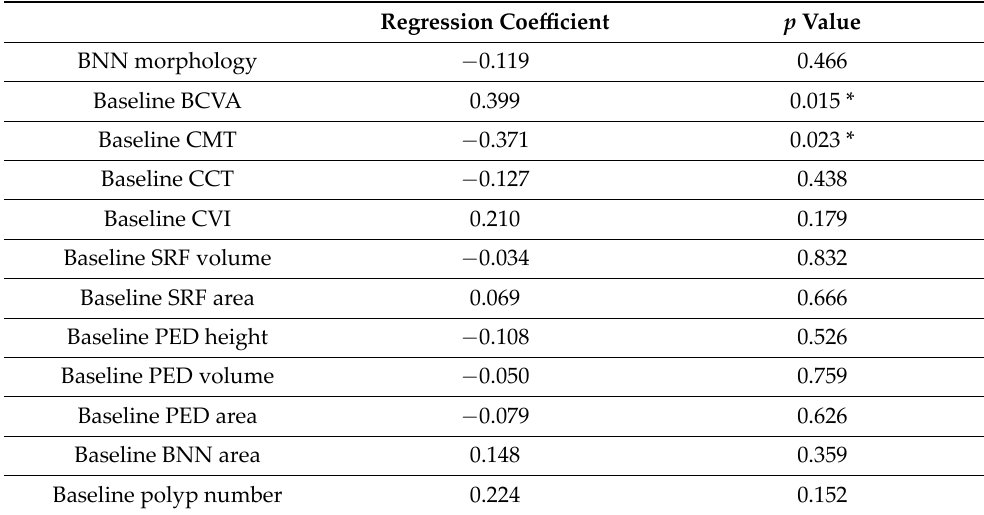
Table 3. Multivariate linear regression analysis for prognostic factors correlated with BCVA at 12 months after anti‑VEGF